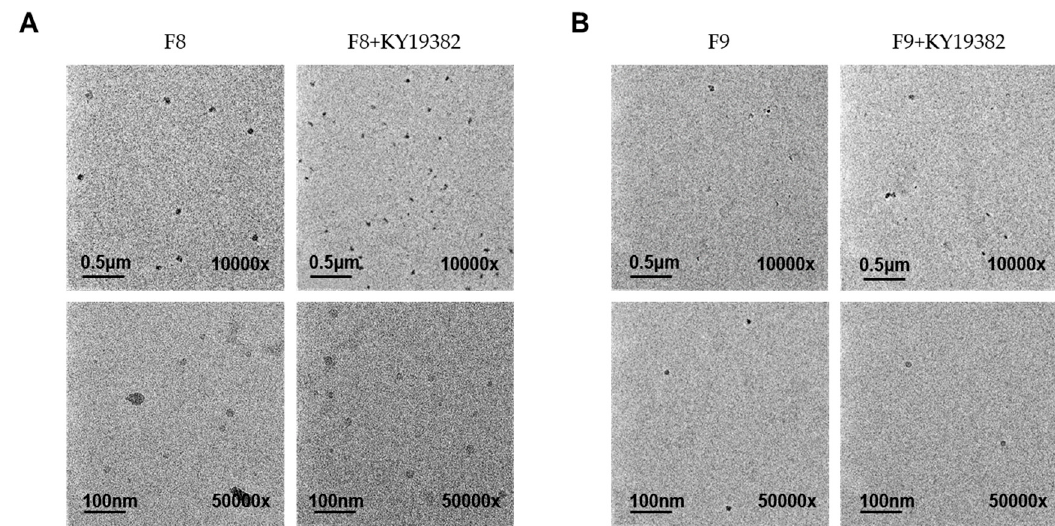
Figure 3. Transmission electronic microscopy (TEM) images of the mixed micellar formation from the ( A ) F8 and ( B ) F9 formulation with or without KY19382. Formulation details are presented in Table 2. The scale bars are 0.5 µm (10,000×) and 100 nm (50,000×), respectively.